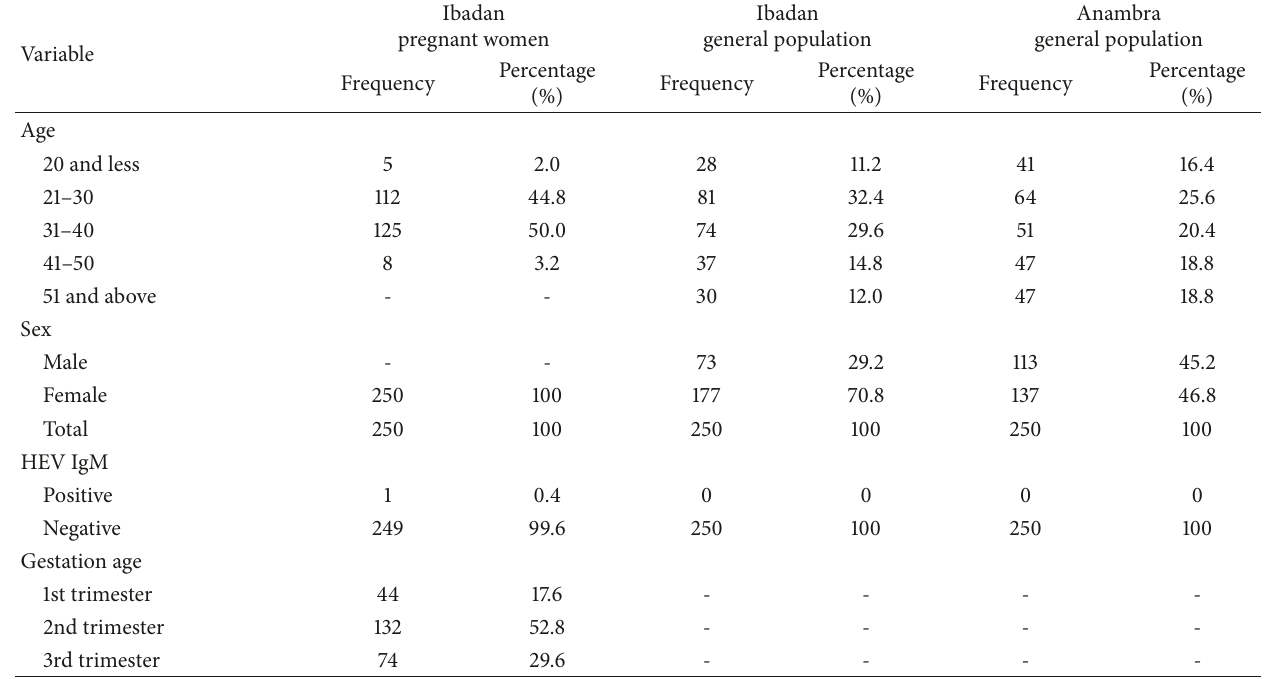
Table 1: Characteristics and HEV IgM prevalence among study participants.